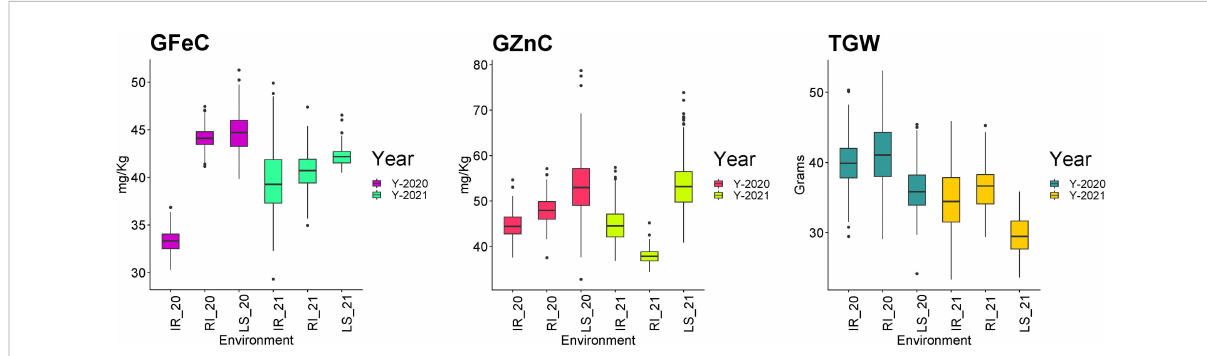
FIGURE 3 Box plot depicting the distribution of grain iron content (GFeC), grain zinc content (GZnC)p, and the 1000-grain weight (TGW) under timely sown irrigated (IR), restricted irrigated (RI) and late sown (LS) conditions across the years 2020 – 2021 and 2021 – 2022.